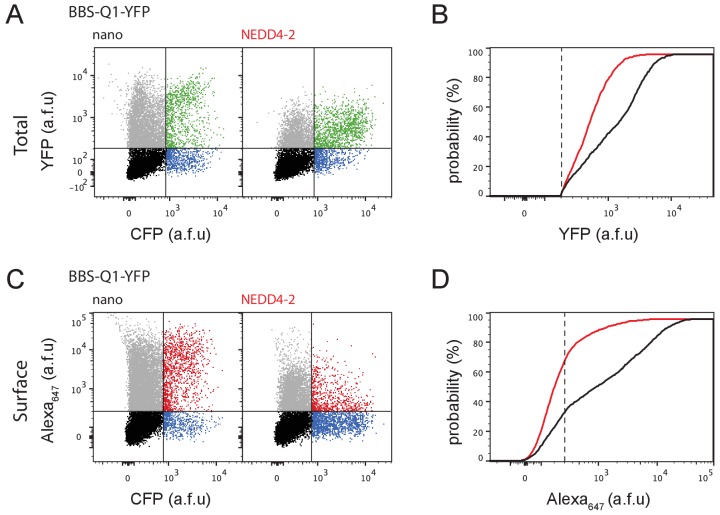
Full-length NEDD4-2 diminishes both Q1 surface density and total protein expression.(A) Flow cytometry analyses of total Q1 expression (YFP fluorescence) in cells expressing BBS-Q1-YFP + nanobody (left, control) or BBS-Q1-YFP + NEDD4-2 (right). (B) Cumulative distribution histograms of YFP fluorescence for BBS-Q1-YFP co-expressed with either nanobody alone (black line) or NEDD4-2 (red line). (C) Flow cytometry analyses of surface Q1 channels (Alexa647 fluorescence) in cells expressing BBS-Q1-YFP + nanobody (left, control) or BBS-Q1-YFP + NEDD4-2 (right). (D) Cumulative distribution histograms of Alexa647 fluorescence for BBS-Q1-YFP co-expressed with either nanobody alone (black line) or NEDD4-2 (red line).